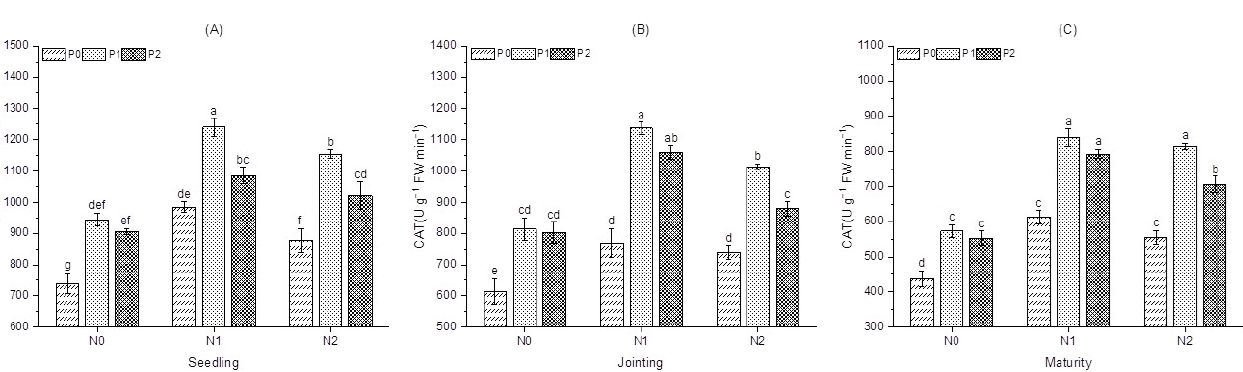
Figure 2. Effects of nitrogen and phosphorus on peroxidase (POD) activity of sorghum plants grown in saline soils at the three growing stages of seedling, jointing, and maturity. ( A ) Seedling stage; ( B ) Jointing stage; ( C ) Maturity stage. Within each sampling date, the data followed by different letters are statistically different at the 0.05 probability level.